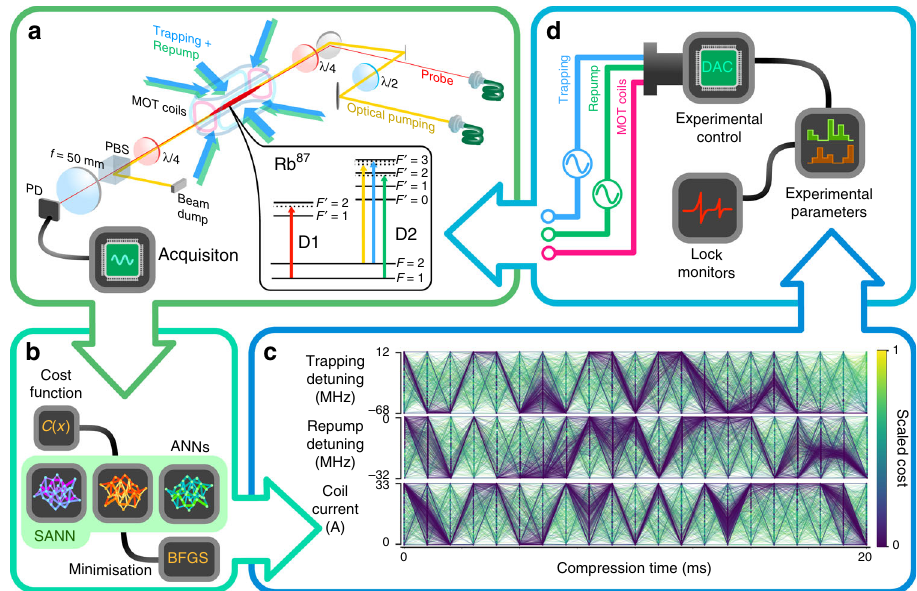
Fig. 1 Online optimisation of optical depth. a Initially a MOT captures thermal 87 Rb atoms via laser cooling. The ensemble is then transiently compressed using a set of 21 time bins for trapping frequency, repump frequency and magnetic fi eld strength. The off resonant OD is measured from the transmission of a probe fi eld incident on a photo detector. This value is passed to the SANN ( b ) where a cost function is calculated for the current set of parameters. Each ANN that comprises the SANN is trained using this and the previous training data. Each ANN generates a parameter set by minimising the predicted cost landscape using the Broyden-Fletcher-Goldfarb-Shanno (BFGS) algorithm. An example of parameter sets that were tested during an experimental run is shown in c . Each line represents one set of parameters that was tried and is coloured by the corresponding measured cost. Each predicted parameter set is sequentially passed to ( d ), the experimental control systems which monitor the lock state of the experiment and convert the parameter set to physical values. This loop continues until either a minimisation condition or maximum run number is